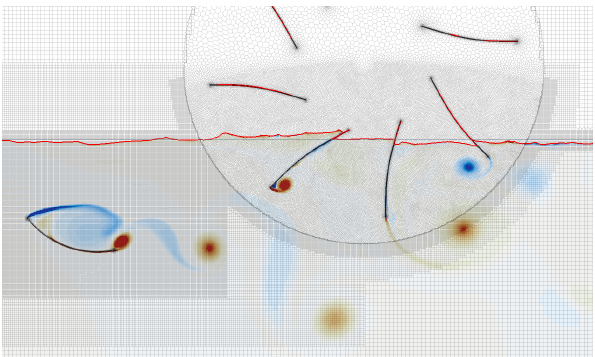
Figure 15. A two-dimensional CFD simulation based on the current work, also steered with a genetic optimiser, as part of the search for an optimal deflector shape to improve the power characteristics of the free-stream waterwheel. The colour scale and visualisation match those of Figure